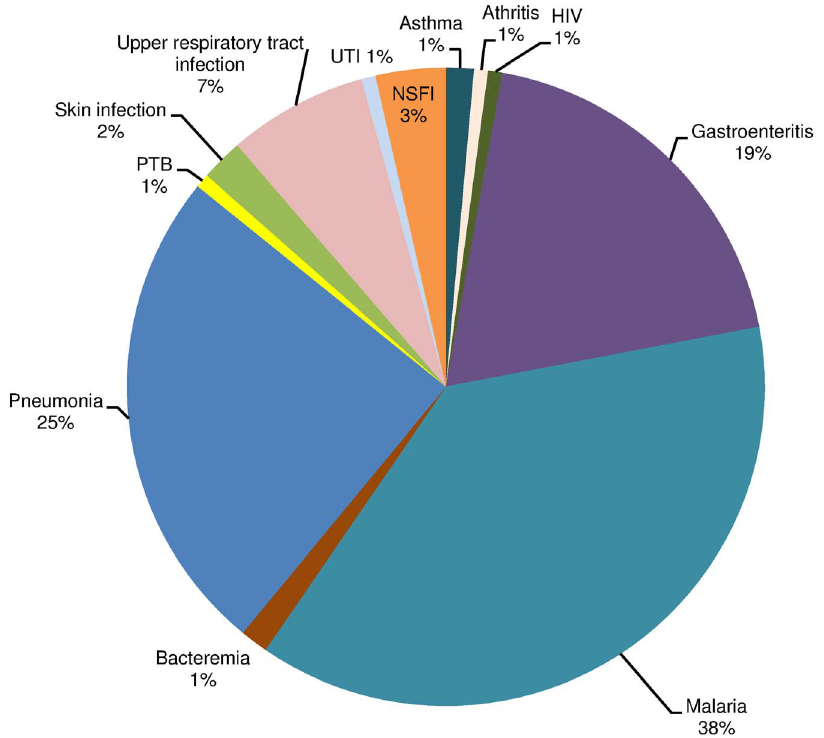
Figure 3. Distribution of illnesses among hospitalised patients at KDH (n=141). doi:10.1371/journal.pone.0104197.g003 PLOS ONE |